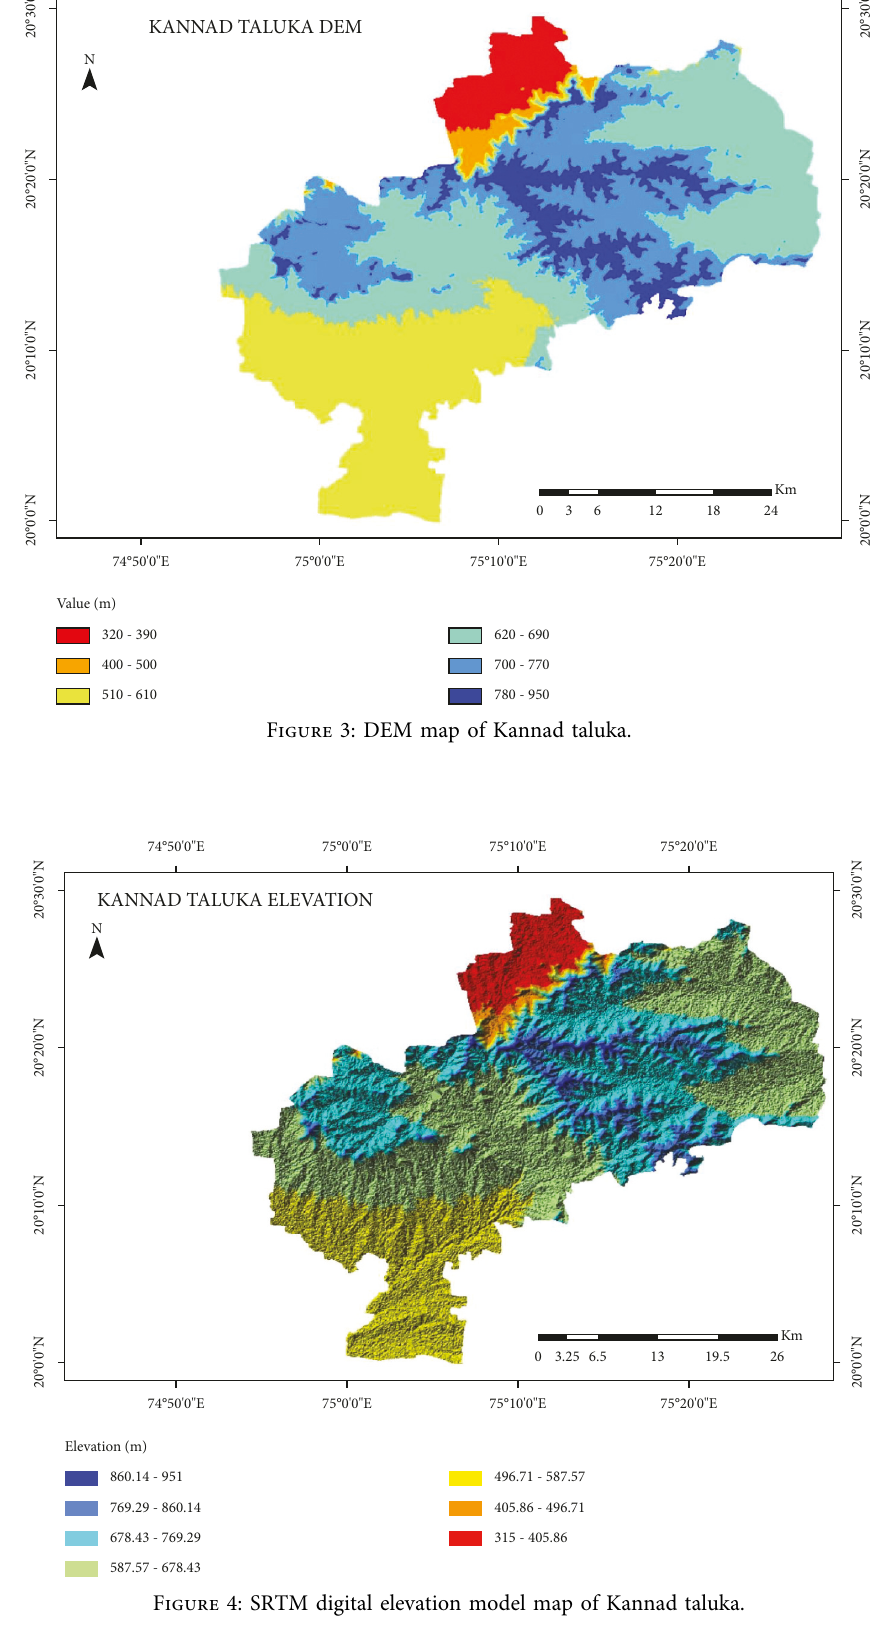
Figure 4: SRTM digital elevation model map of Kannad